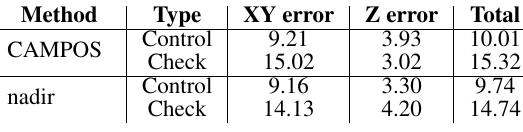
Table 2. GCPs root mean square error, units in centimeters.